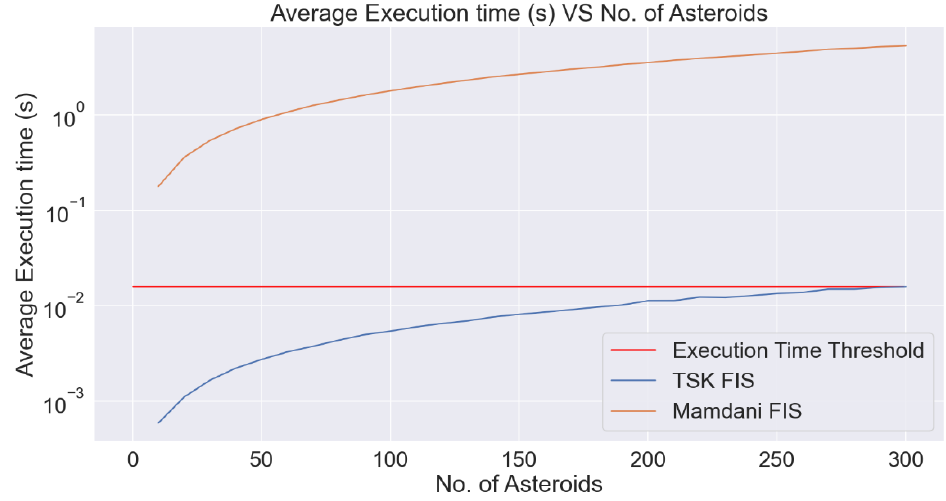
Figure 10. Mamdani vs. TSK execution time benchmark. Algorithm 2: XAI Core Execution Time Benchmark Algorithm 3: XAI Core Noise Benchmark